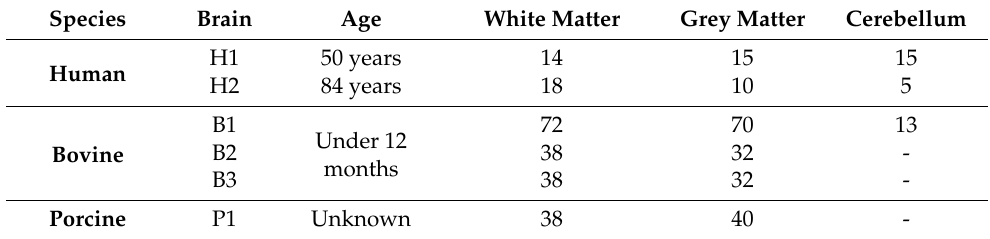
Table 1. The number of measurement points per tissue and species